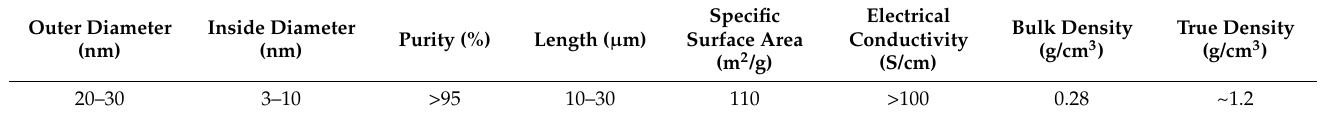
Table 1. Specifications of MWCNT used in the present